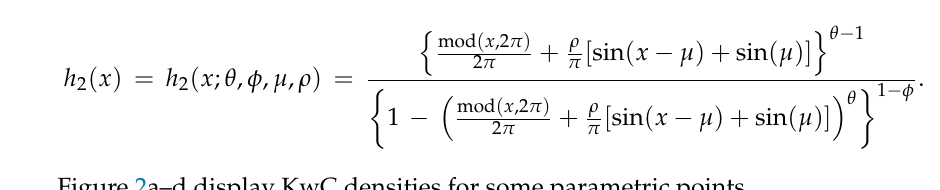
Figure 2a–d display KwC densities for some parametric points.